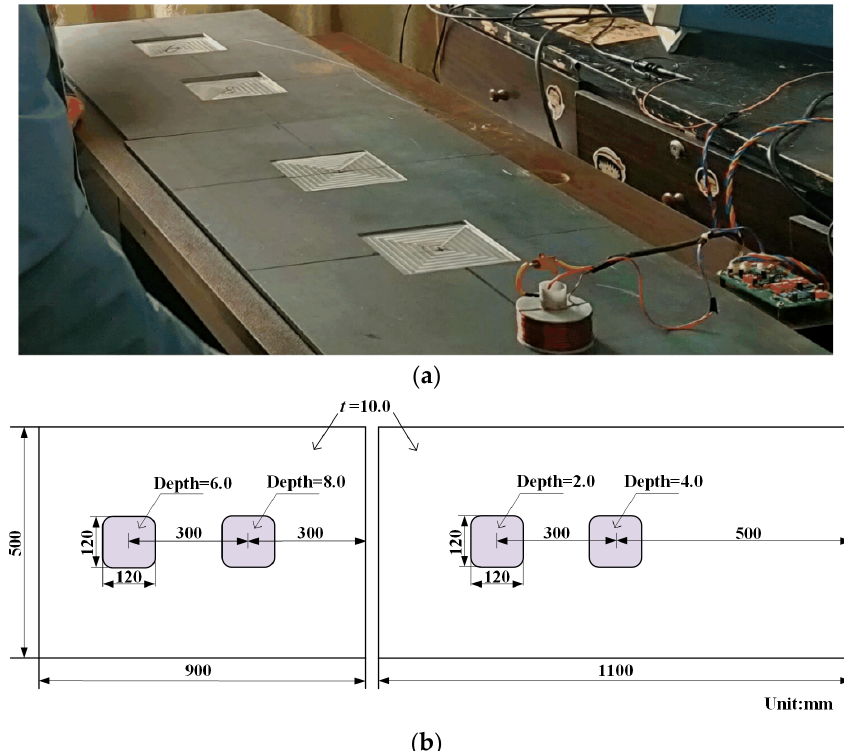
Figure 10. ( a ) Photo and ( b ) dimensions of the sample plates machined with wall thinning defects.